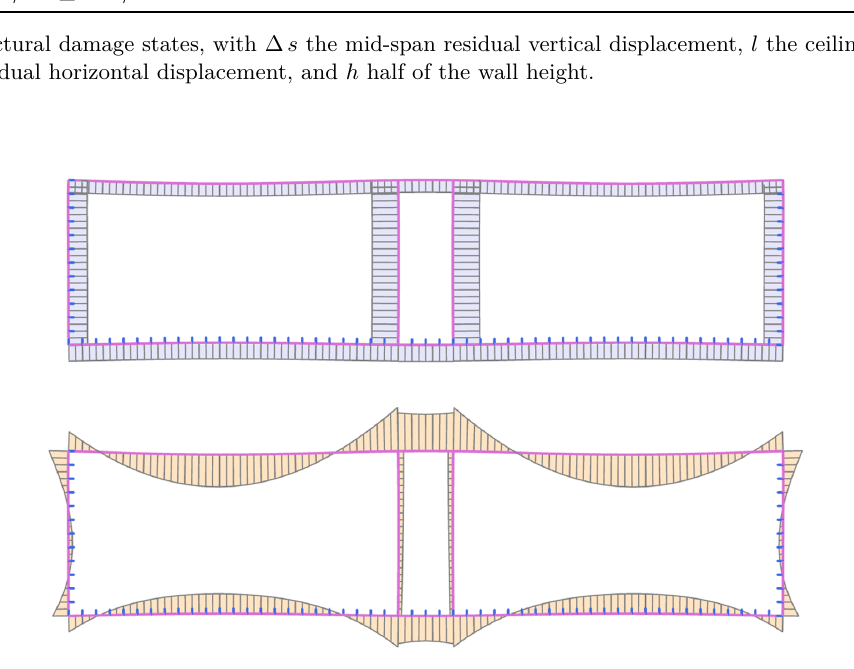
Figure 4. Axial force (top; compression blue) and bending moment (bottom) before the